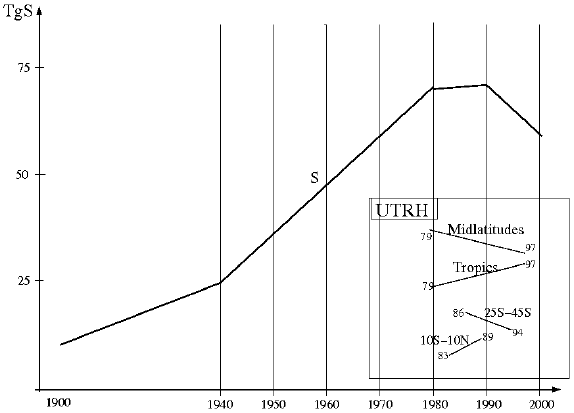
Fig. 2. A schematic representation of global emissions of sul- fur from Stern (2006) and UTRH changes from McCarthy and Figure 2. A schematic representation of global emissions of sulfur from Stern (2006) and 6 Toumi (2004) in midlatitudes, tropics, and two different latitude UTRH changes from McCarthy and Toumi (2004) in midlatitudes, tropics, and two different 7 bands. UTRH has decreased everywhere except in the tropics and latitude bands. UTRH decreased everywhere except in the tropics and north of 40 N in 1979-8 north of 40 ◦ N in 1979–1997. It is argued that this decrease may 1997. It is argued that this decrease may be related to the global decrease of sulfur emissions. 9 be related to the global decrease of sulfur emissions. The particu- The particularly strong increase of UTRH in the tropics in 1983-1989 may be associated with 10 larly strong increase of UTRH in the tropics in 1983–1989 may be high desert dust levels and increases in the biomass burning in South America. See text for 11 associated with high desert dust levels and the increase in biomass details. 12 burning in South America. See text for